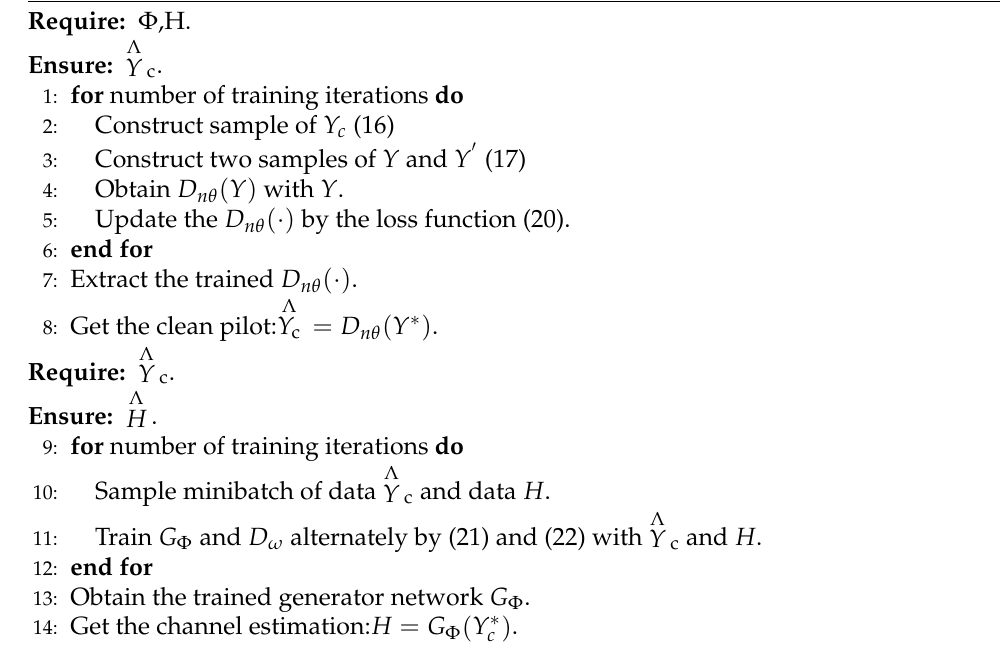
Algorithm 1 N2N-cGAN-Based Channel